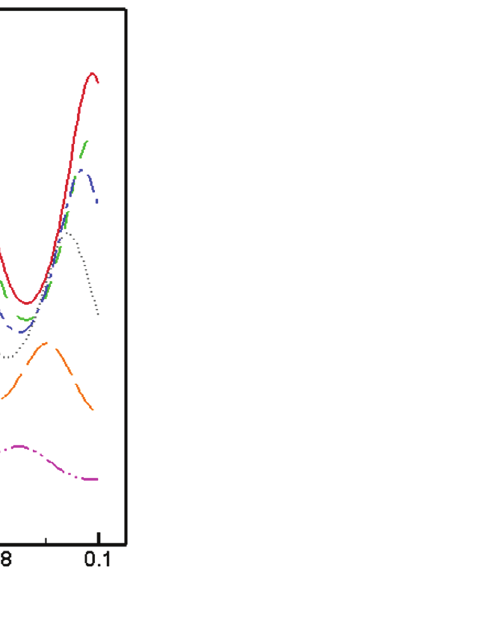
Figure 6: Temperature dependence of PTC of the mullite slab as the thickness varies from 0 to 0.1 m at 2,450 MHz: 27°C, 200°C, 400°C, 800°C, 1,000°C.